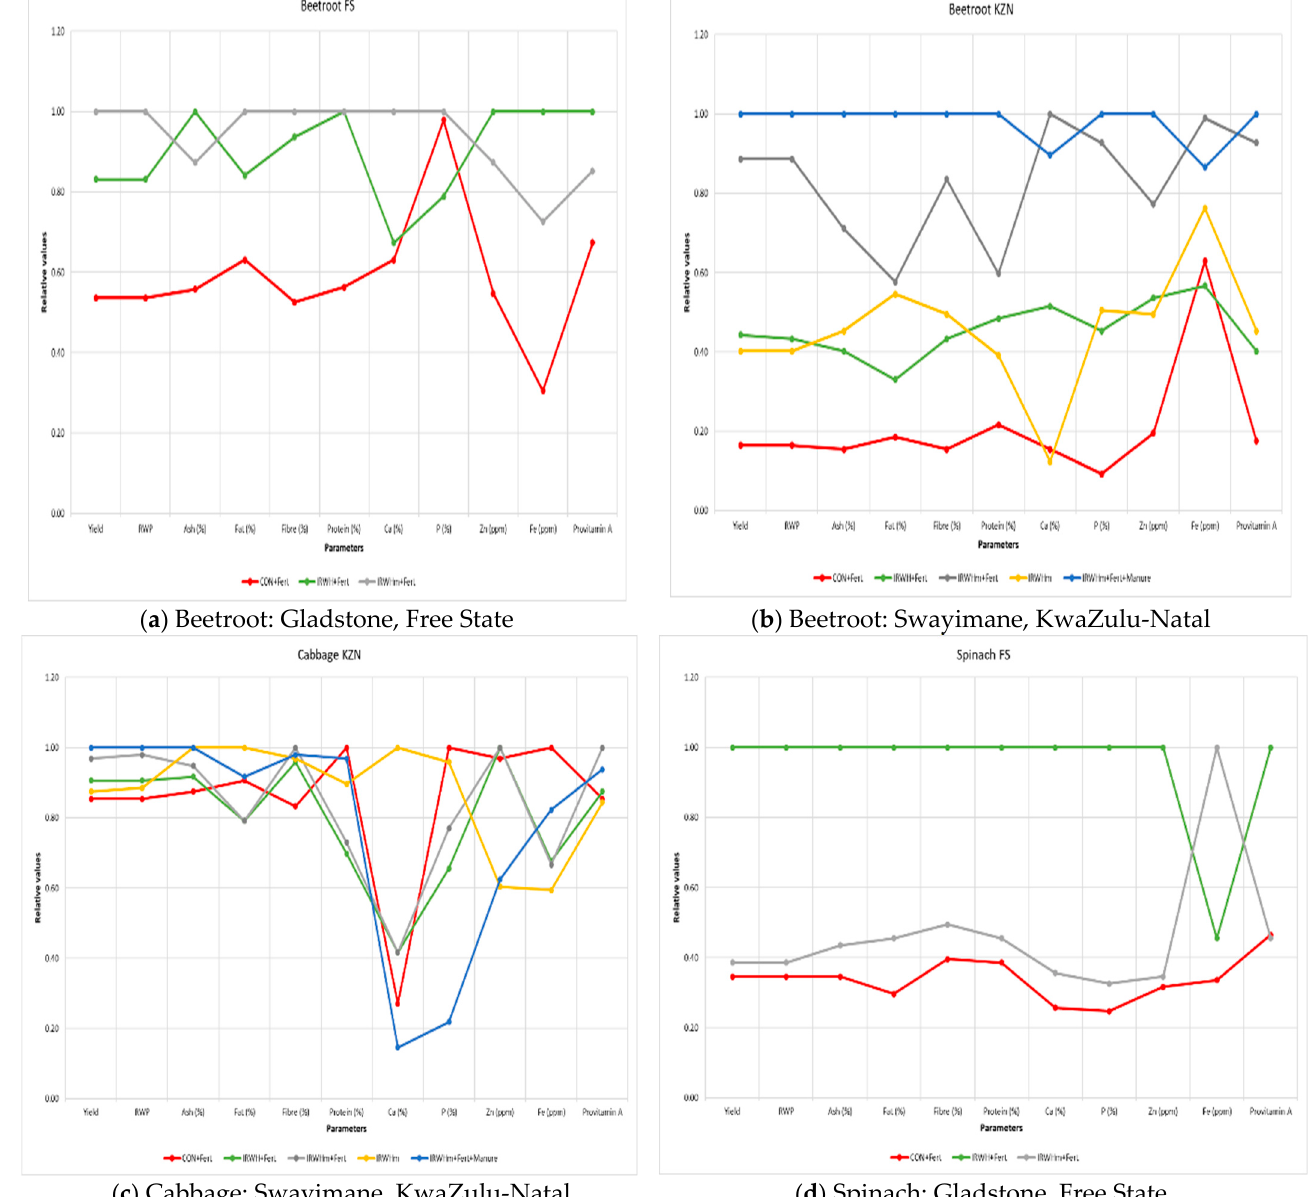
Figure 1. Relative values of yield and nutrient content for various vegetable crops grown in Gladstone and Swayimane under different agronomic treatments and water-use technologies.